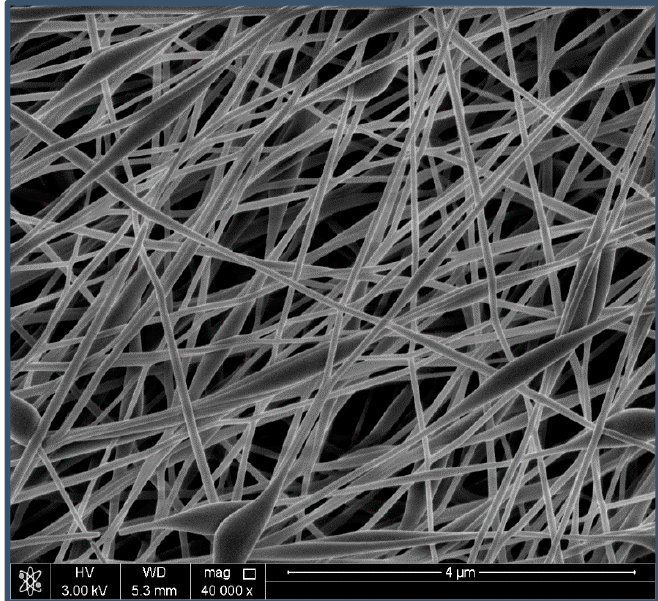
Figure 1. Scanning electron microscopy images at 40,000 × of electrospun nanofibers of PVA/chitosan/AgNPs blends at PVA/Chitosan a concentration of 12/4.7 wt/wt%, respectively, using the electrospinning conditions of 10 cm, 18 kV, and 0.3 mL/h.